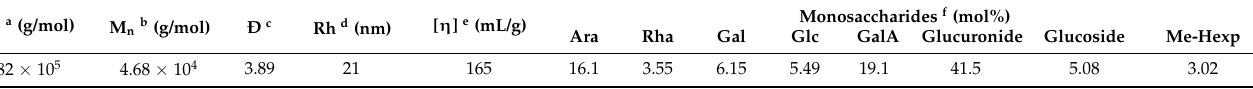
Table 2. Characterization of CFPS fraction extracted from Clematis flammula